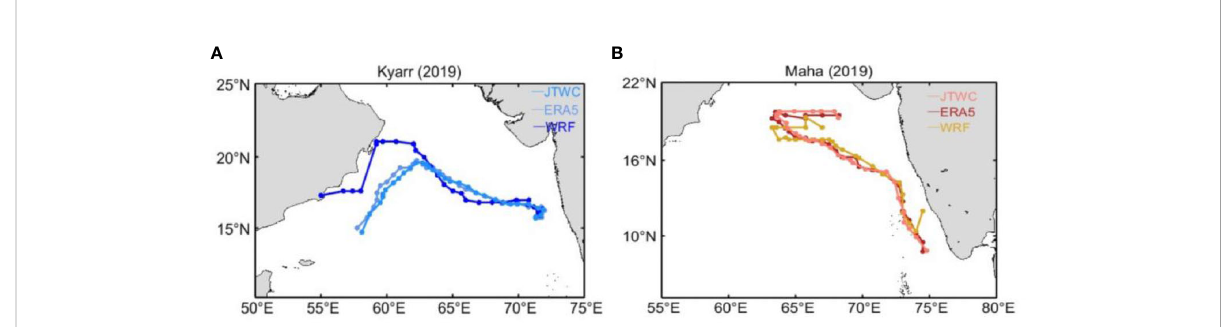
FIGURE 4 Evolution of the SST before, during and after Kyarr and Maha. (A) : before Kyarr, (B, C) : during Kyarr, (D) : after Kyarr and before Maha, and (E – H) : after Kyarr and during Maha. The black and red lines denote the tracks of Kyarr and Maha, respectively. The grey and red dotted lines represent that the TCs have not passed through the regions. The black and red solid dots denote the centre locations of Kyarr and Maha at 00:00 UTC, respectively. The black boxes represent typical regions with distinct sea surface